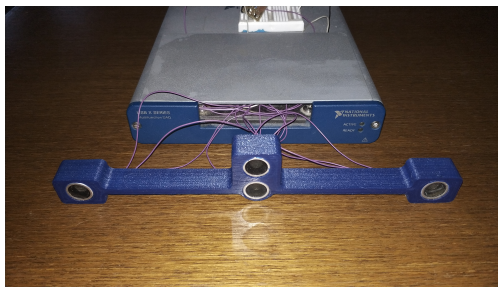
Figure 11. Test system built up with a National Instruments measuring unit.